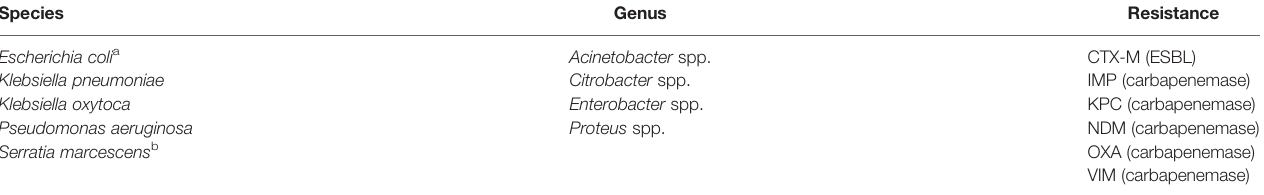
TABLE 2 | Targets included in the VERIGENE Gram-Negative Blood Culture test. Species